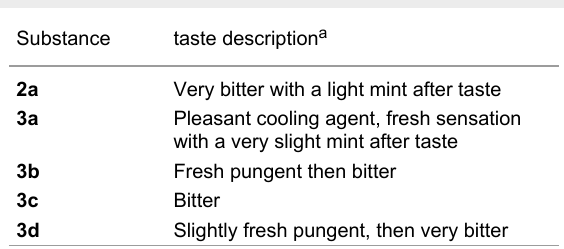
Table 3: Sensorial evaluation of